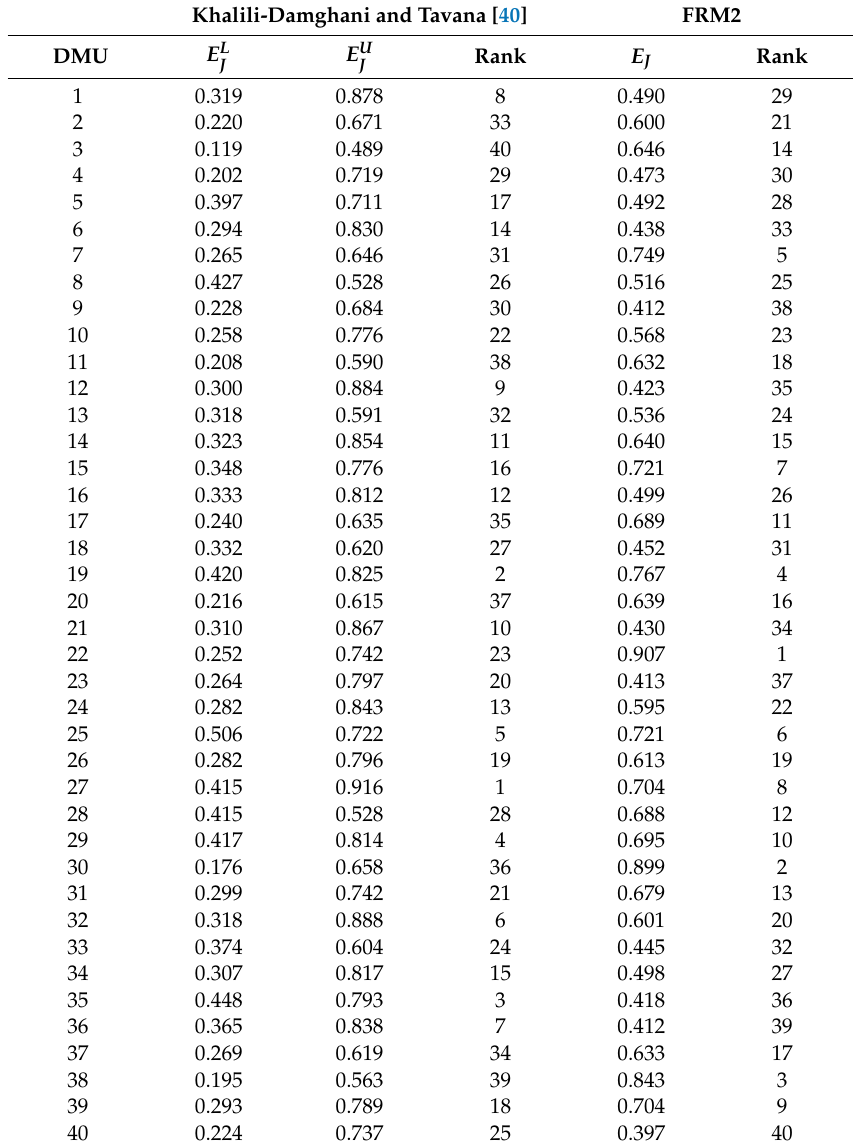
Table 3. Results of Khalili-Damghani and Tavana [40] and Fuzzy Ranking Method 2 (FRM2) for dataset